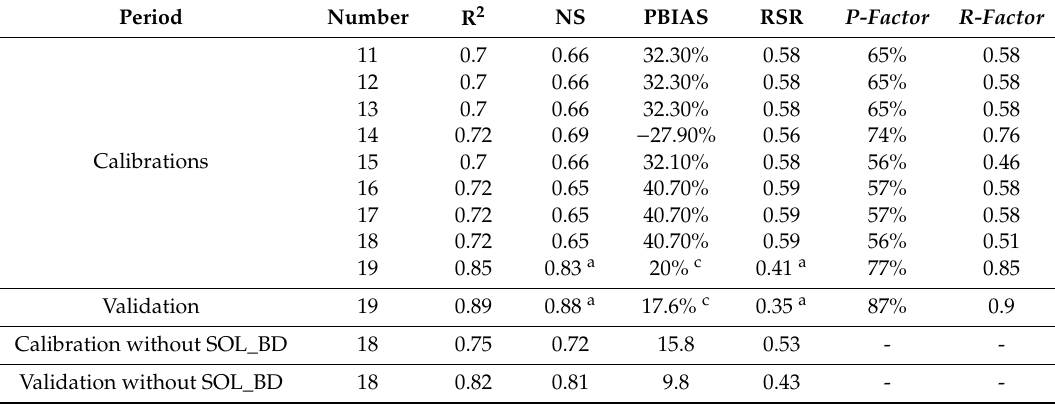
Table 4. Performance of SWAT model calibration by using di ff erent numbers of parameters according to the sensitivity ranking and validation by using 19